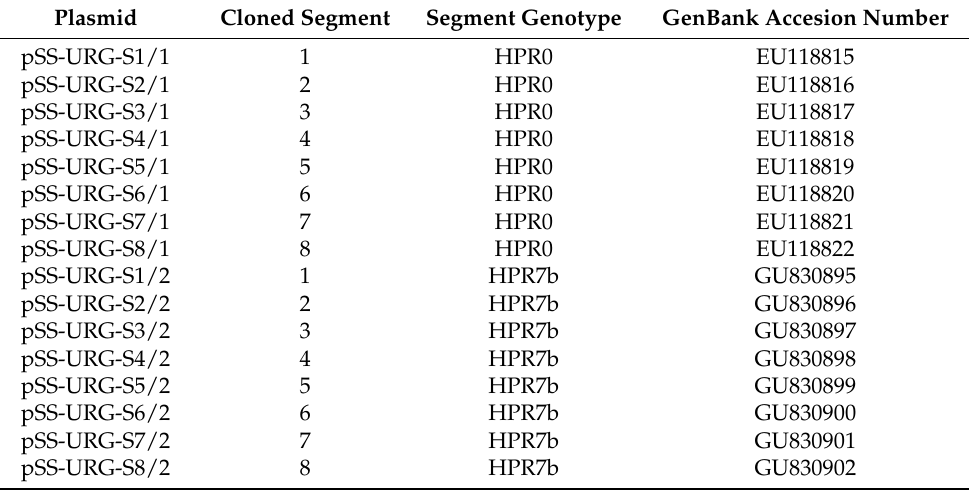
Table 1. GenBank accession number for the viral strains used for reverse genetics plasmids construction. Plasmid Cloned Segment Segment Genotype GenBank Accesion